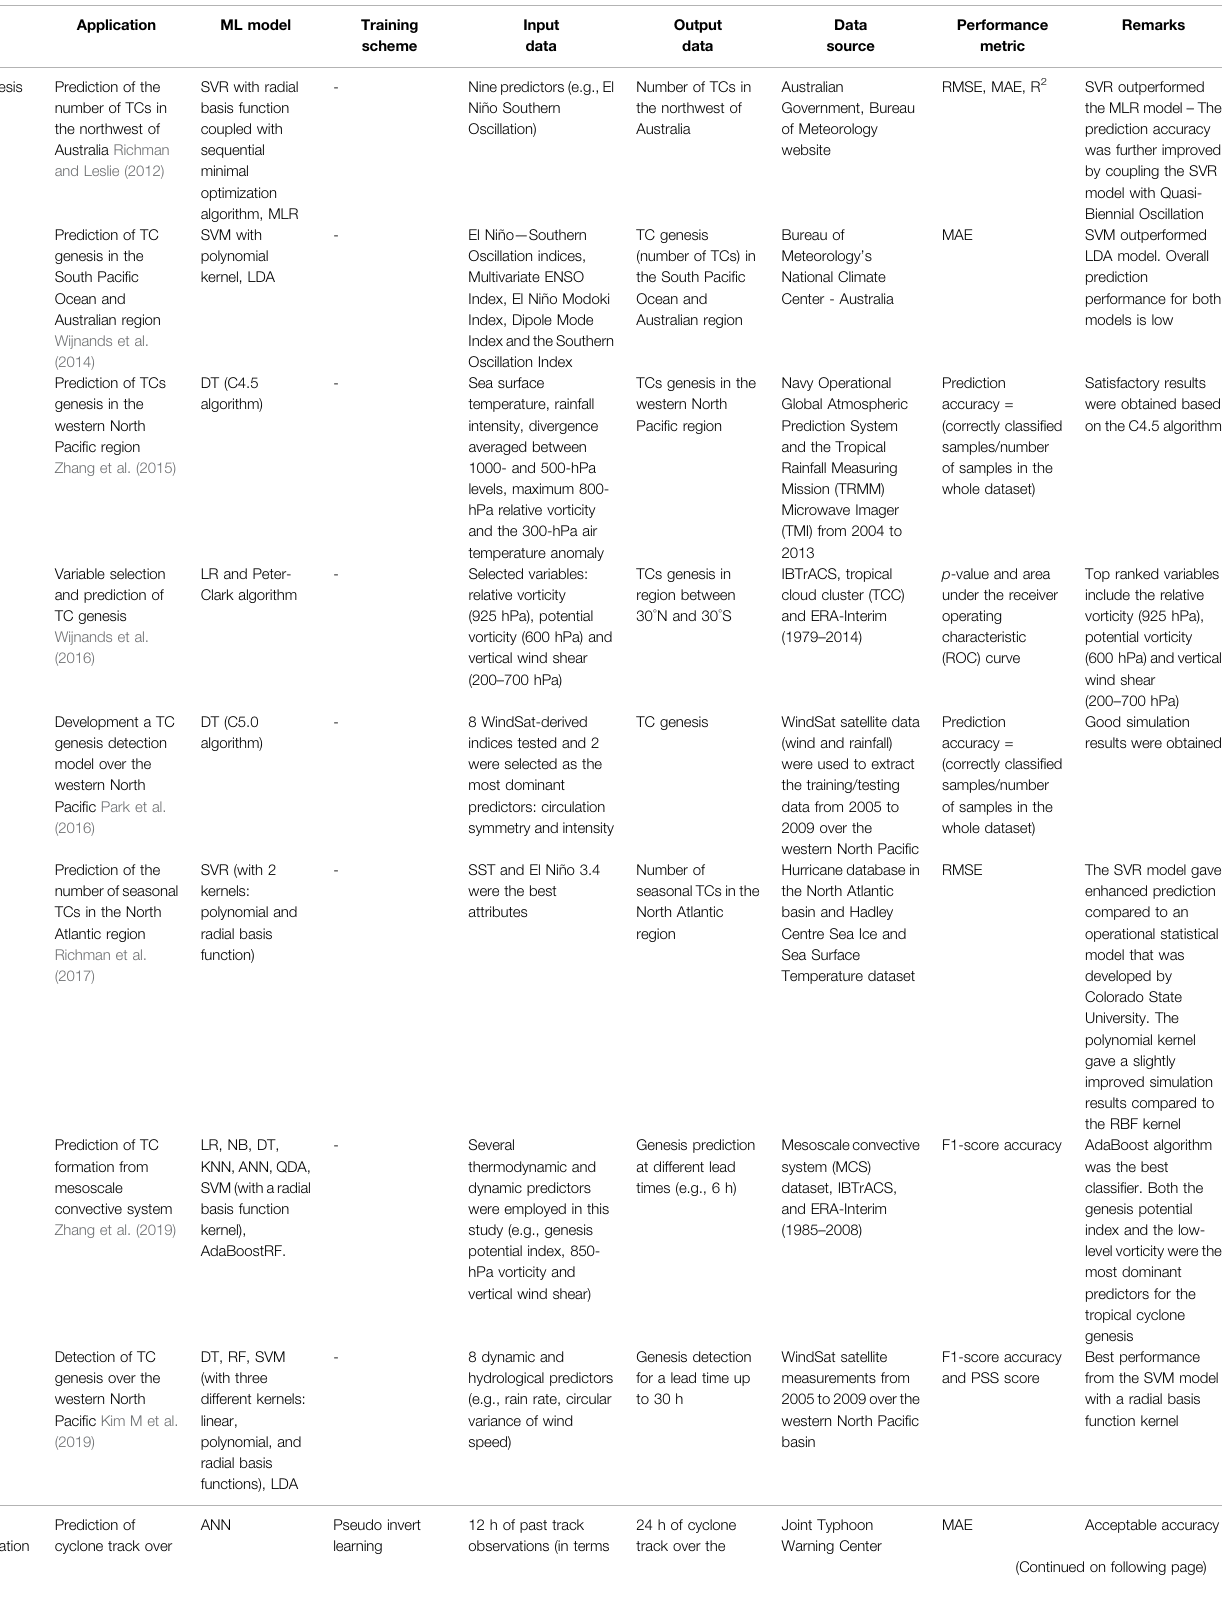
TABLE 2 | Summary of ML applications for tropical